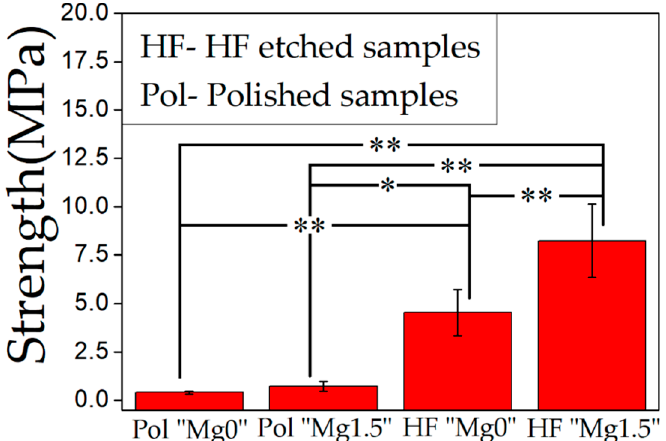
Figure 8. Comparison of adhesive strength of the HAp layer on only polished (Pol) and HF-etched and subsequently “Mg0” solution-treated and “Mg1.5” solution-treated 3Y-TZP formed by 14 days SBF immersion. The symbol “**” indicates p < 0.01, “*” indicates p < 0.05 and the no symbol indicates p > 0.05 by one-way ANOVA followed by the Tukey’s tests.